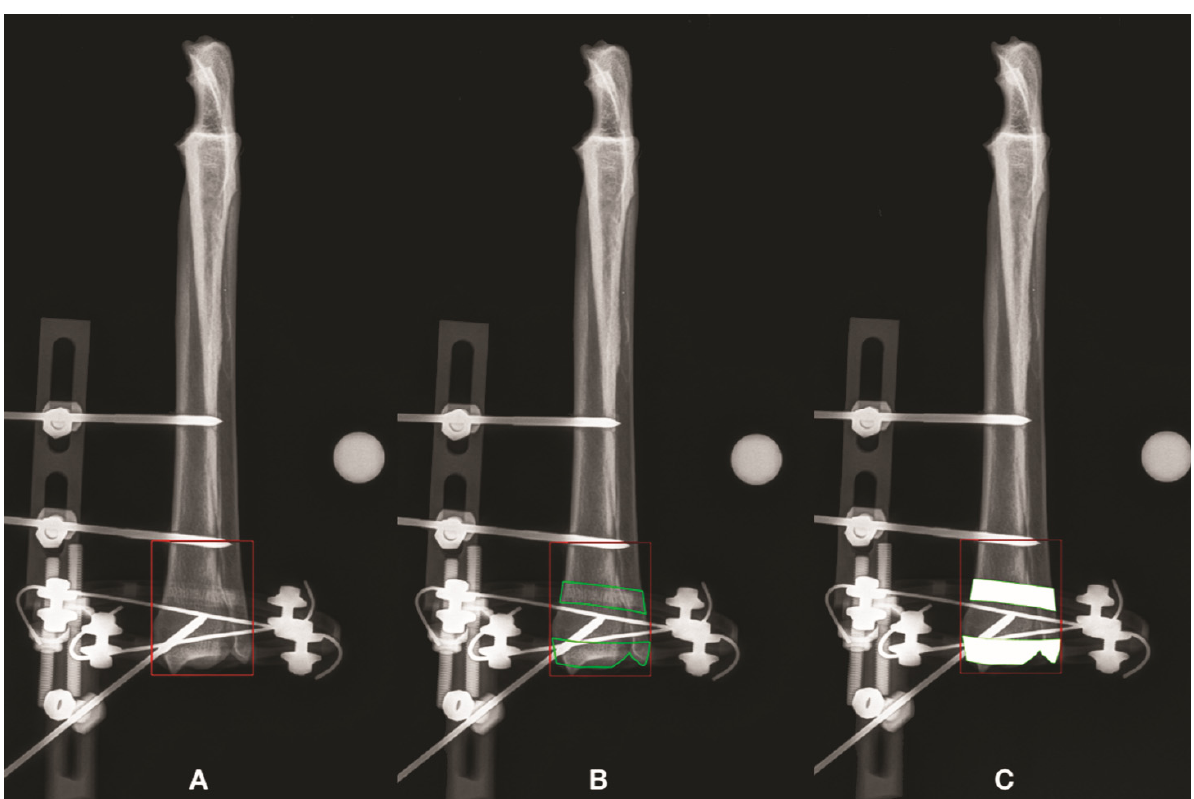
Figure 3. Radiographic pictures showing FA, RLA and ROA for the CrCd projection of the radius- ulna. The FA is illustrated and its extent was calculated ( A ). The RL window represents the area inside the FA where it is possible to see the bone, either not superimposed on radiopaque elements of the frame or superimposed on the radiolucent component of the frame. The latter bone areas are represented by the green areas ( B ). Finally, the radiolucent frame inside the FA was converted into solid white areas, as if it was metallic. These areas were subtracted from the FA to obtain the ROA ( C ). The same procedure was done for each bone segment and for each CrCd and ML projection .